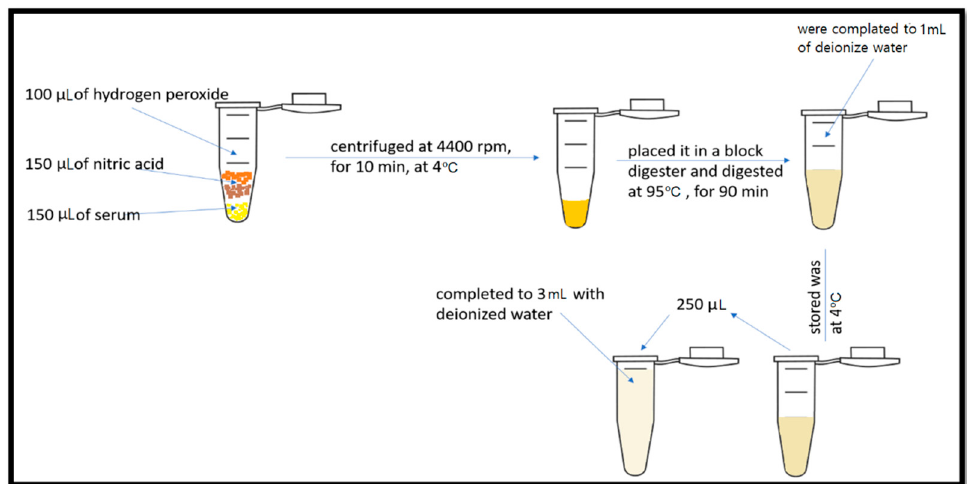
Figure 4. Preparation steps of the sample for the high-resolution sector field ICP-MS.